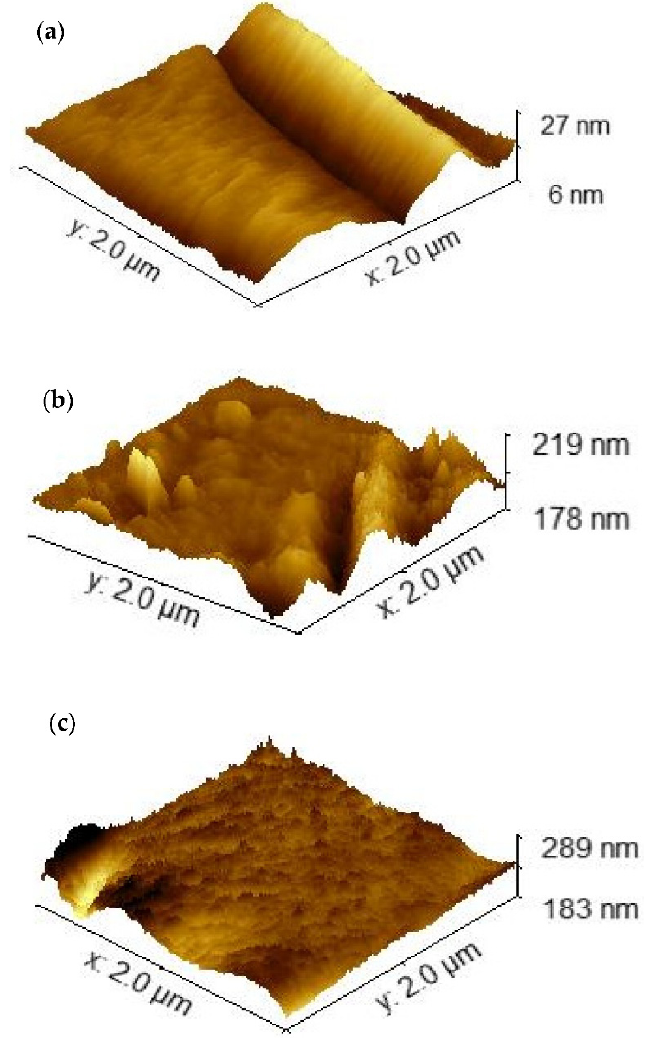
Figure 4. AFM images of ( a ) LIC, ( b ) LIC/PANI and ( c ) LIC/MWCNT-PANI. Table 1. Surface area and roughness of LIC, LIC/PANI and